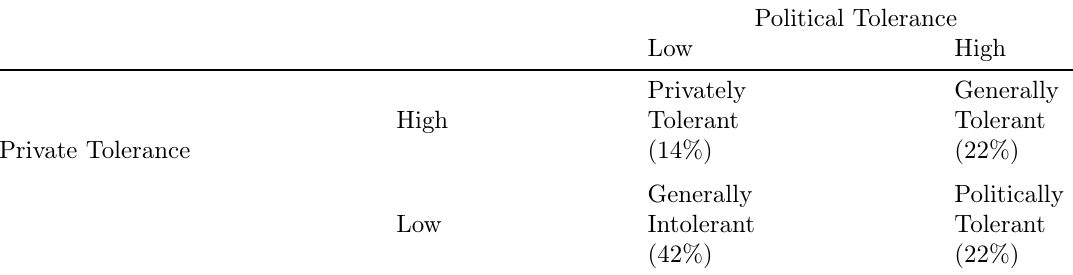
Table 6: 2 × 2 Table of